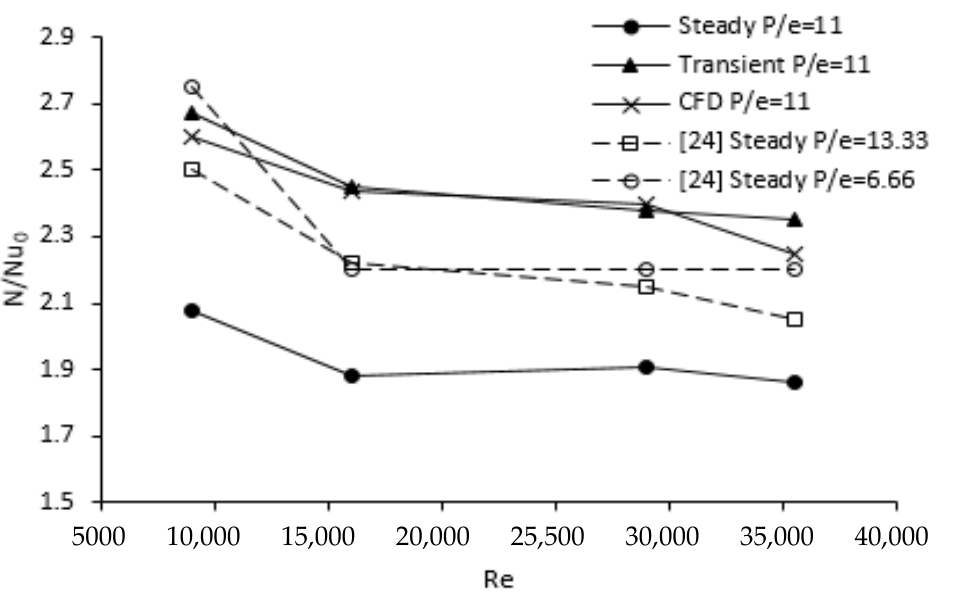
Figure 23. Experimental and normalized Nusselt number versus the Reynolds number obtained by the authors and Tanda and Abram [25] for Configuration_4.